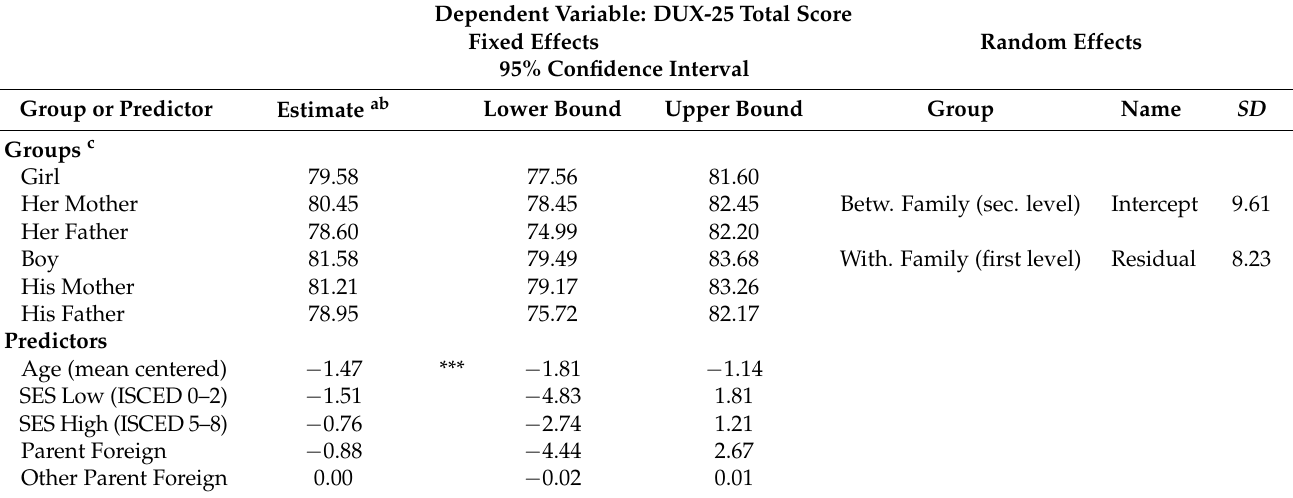
Table 3. Multi Level Model, DUX-25 Total Score by Family Member, Age, SES and